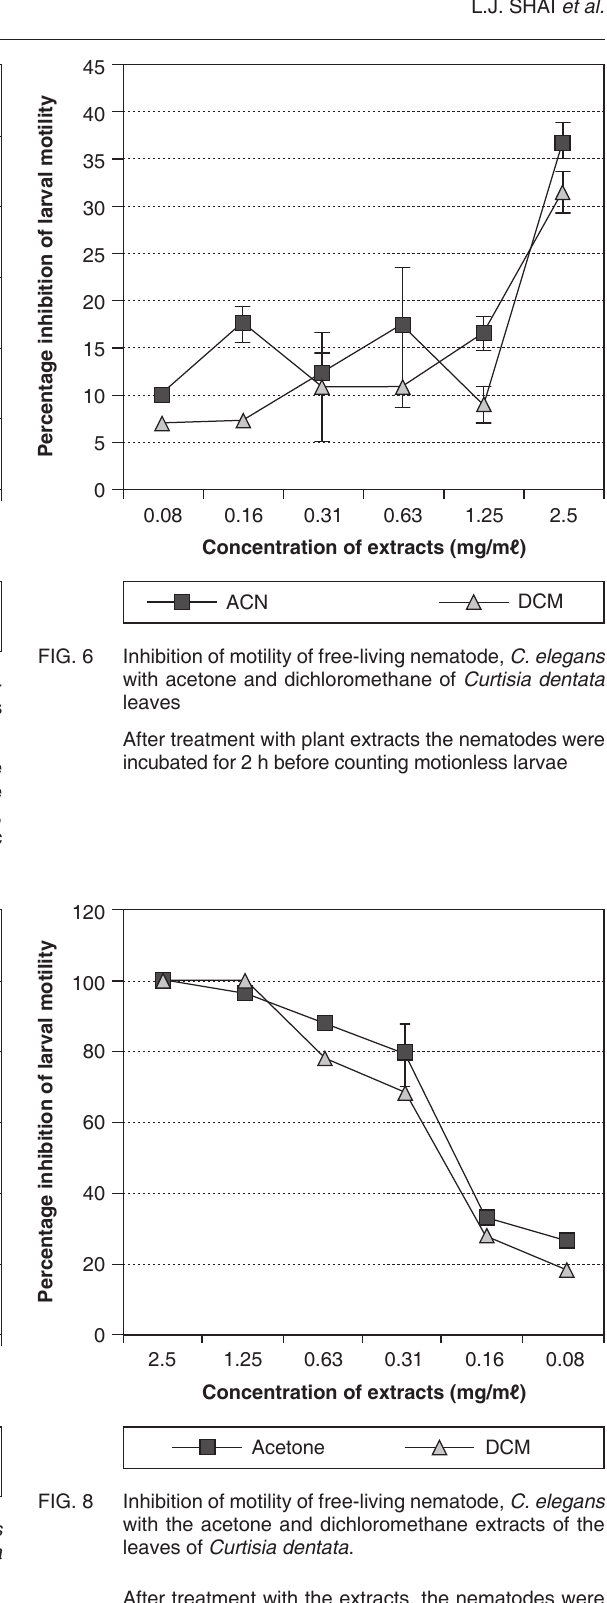
After treatment with the extracts, the nematodes were incubated for 7 d before counting of motionless and motile larvae. The calculated LC m ℓ for both